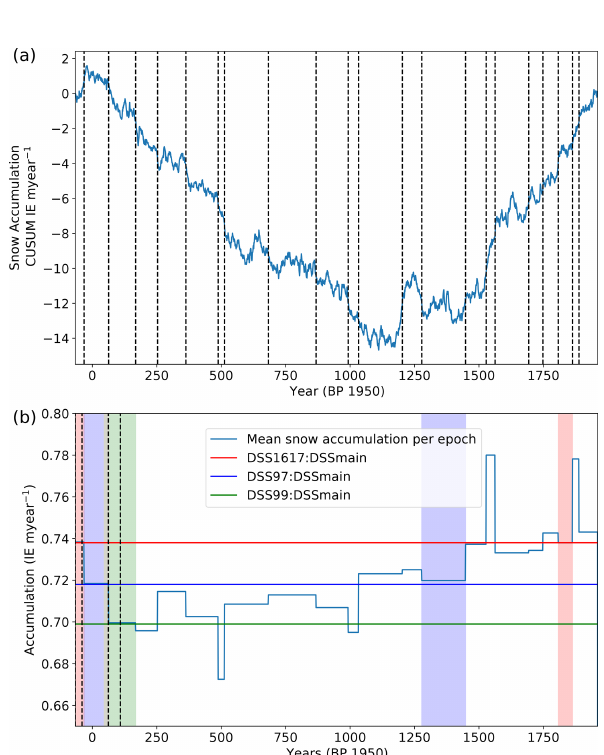
Figure B1. (a) Cumulative sum of the annual snow accumulation rate with detected change points indicated by vertical dashed lines. (b) Average snow accumulation epochs used for chemistry data sta- tistical